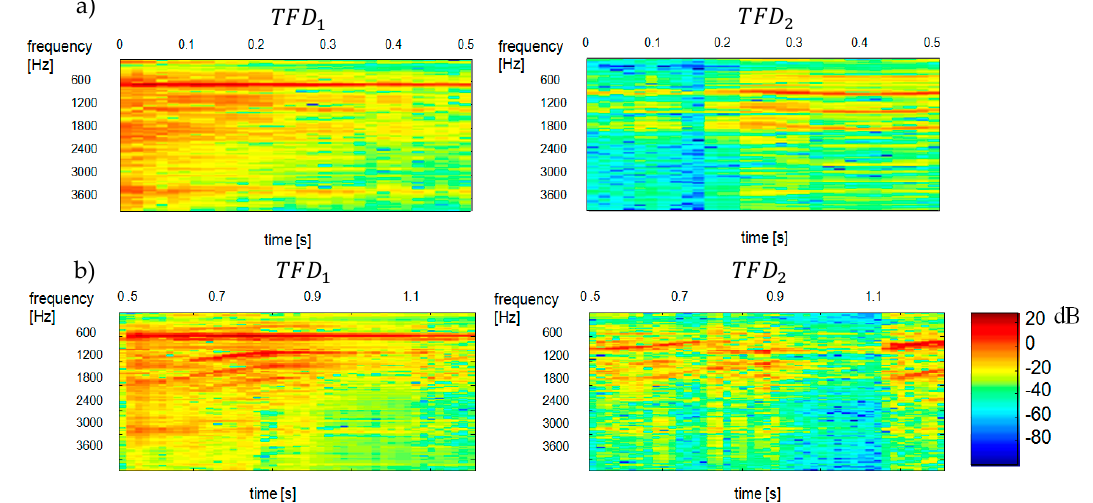
Figure 8. Reconstructed spectrograms (spectra) of TFD 1 and TFD 2 components obtained by minimizing